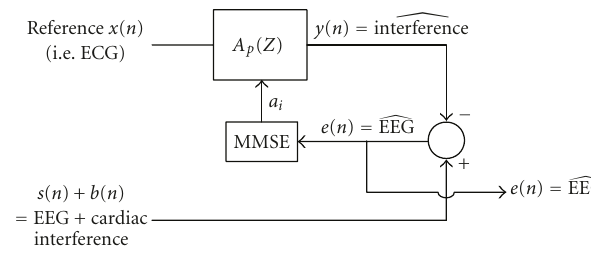
Figure 7: ECG artifact correction by adaptive